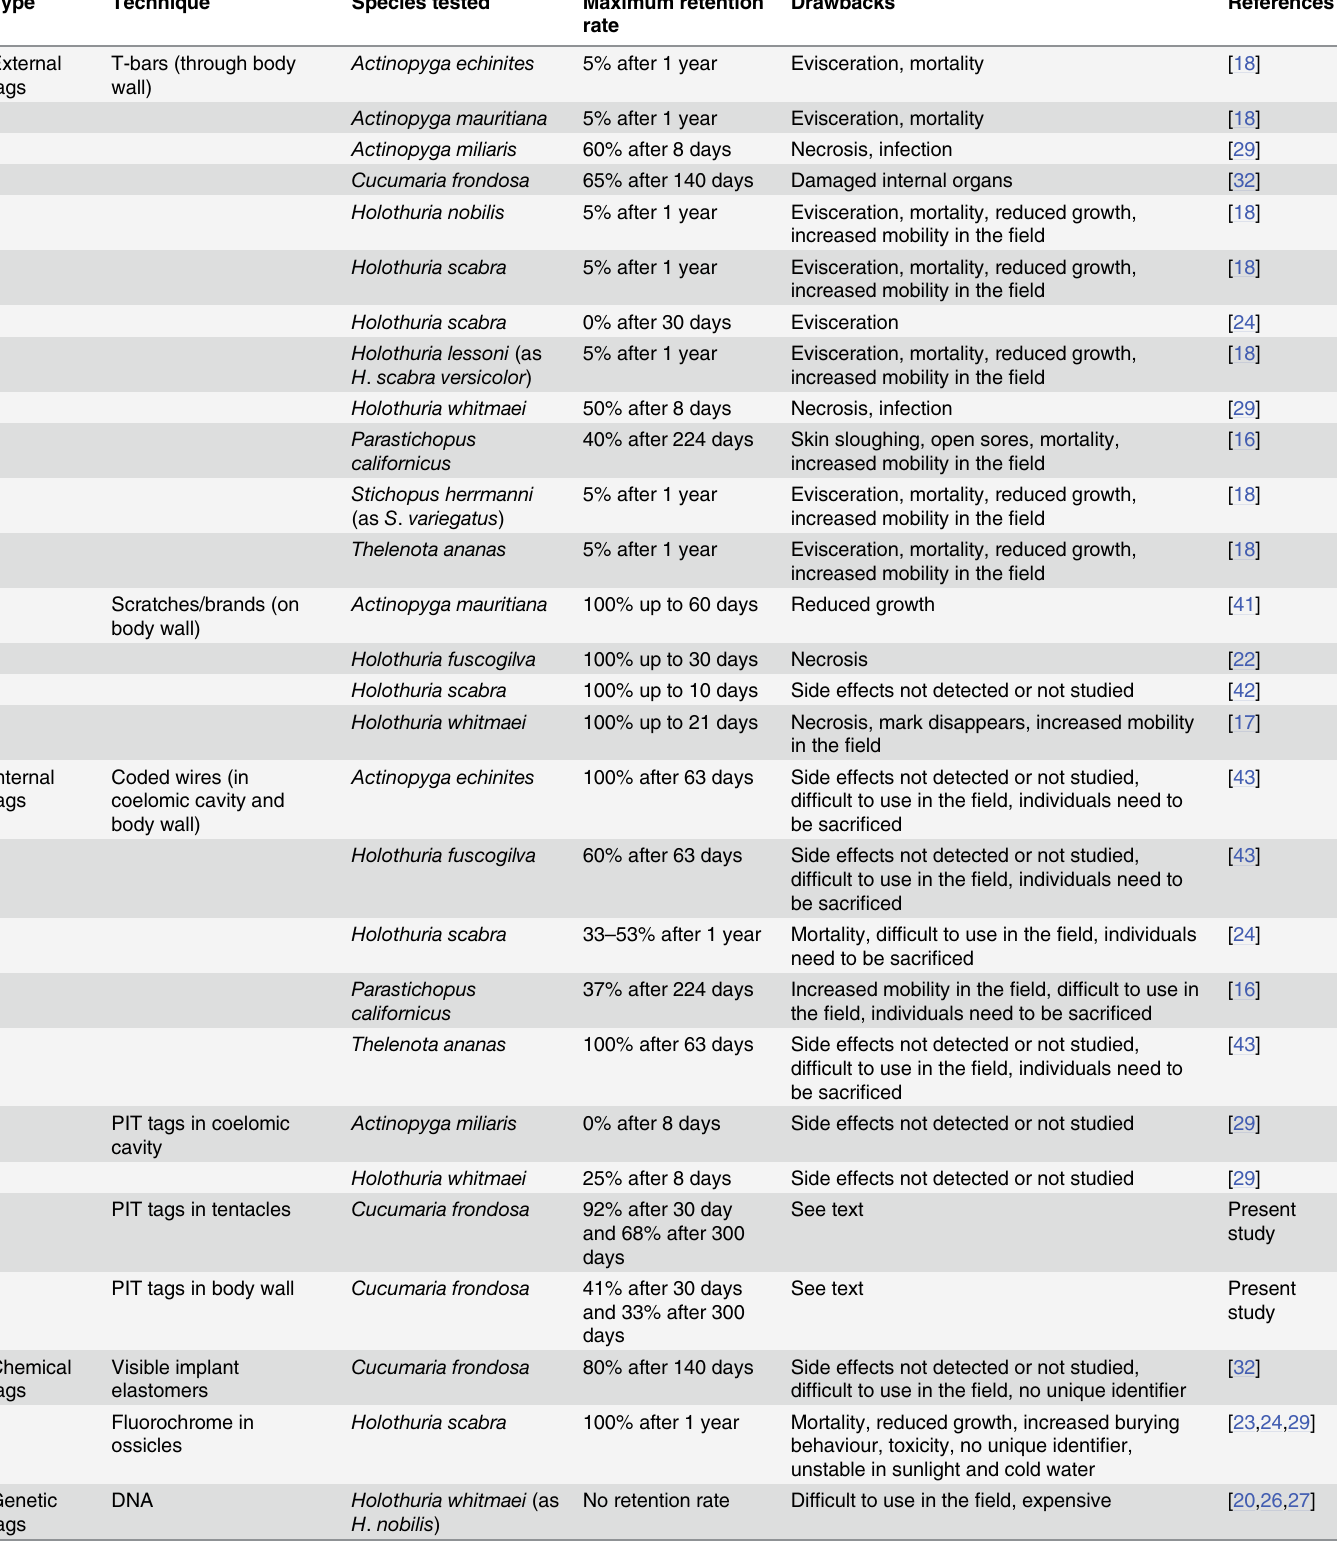
Table 1. Summary of markers tested in sea cucumbers with retention rates and drawbacks of each tagging